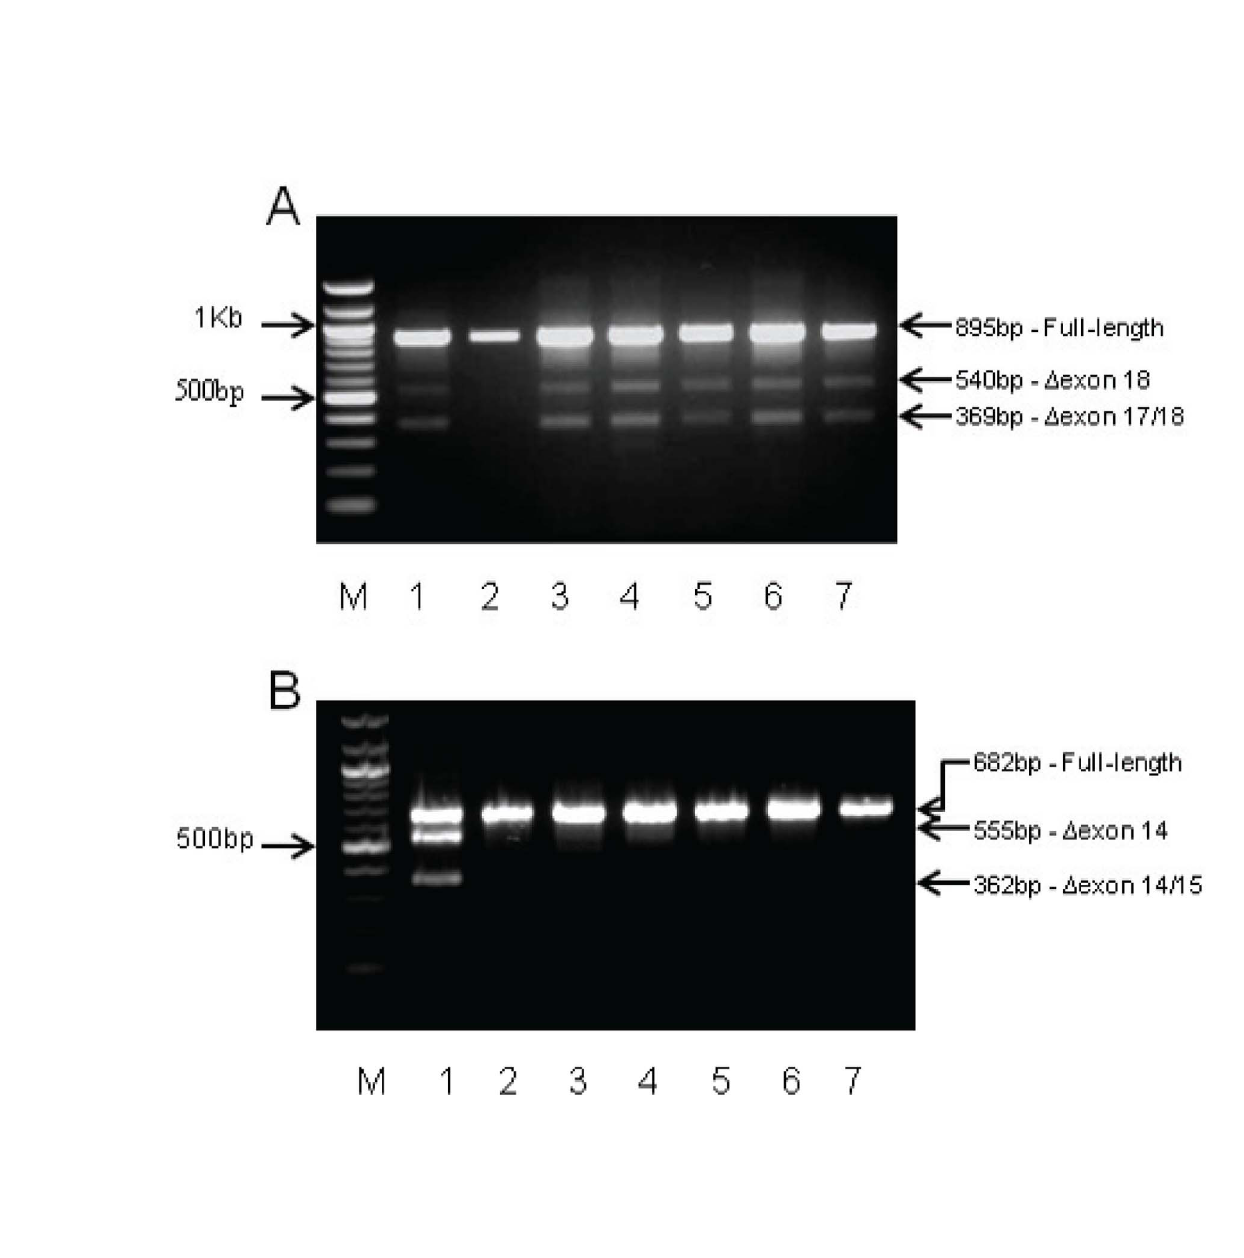
Figure 1. RT-PCR results for BRCA1 c.4484G . C(p.Arg1495Thr) and BRCA2: c.7828G . A (p.Val2610Met). M - 100bp DNA marker (New England Biolabs). A) BRCA2 :c.7828G . A (p.Val2610Met). Lane 1: RT-PCR products from variant carrier derived cycloheximide treated LCL. Lane 2–7: Cycloheximide treated LCLs from unaffected female controls. There is no evidence for a predicted loss of 149bp from exon 17 as a result of a de novo donor site. The D exon 18 (540bp) and D exon 17/18 (369bp) are detected in the variant carrier and all but one control samples. B) BRCA1 c.4484G . C(p.Arg1495Thr). Lane 1: RT-PCR products from whole blood derived RNA from the variant carrier showing the D exon 14 and D exon 14/15 splicing aberration. Lane 2: RT-PCR carried out on whole blood derived RNA from an unaffected female control (collection and extraction methods as per the variant carrier). Lane 3–7: Cycloheximide treated LCLs from unaffected female controls.